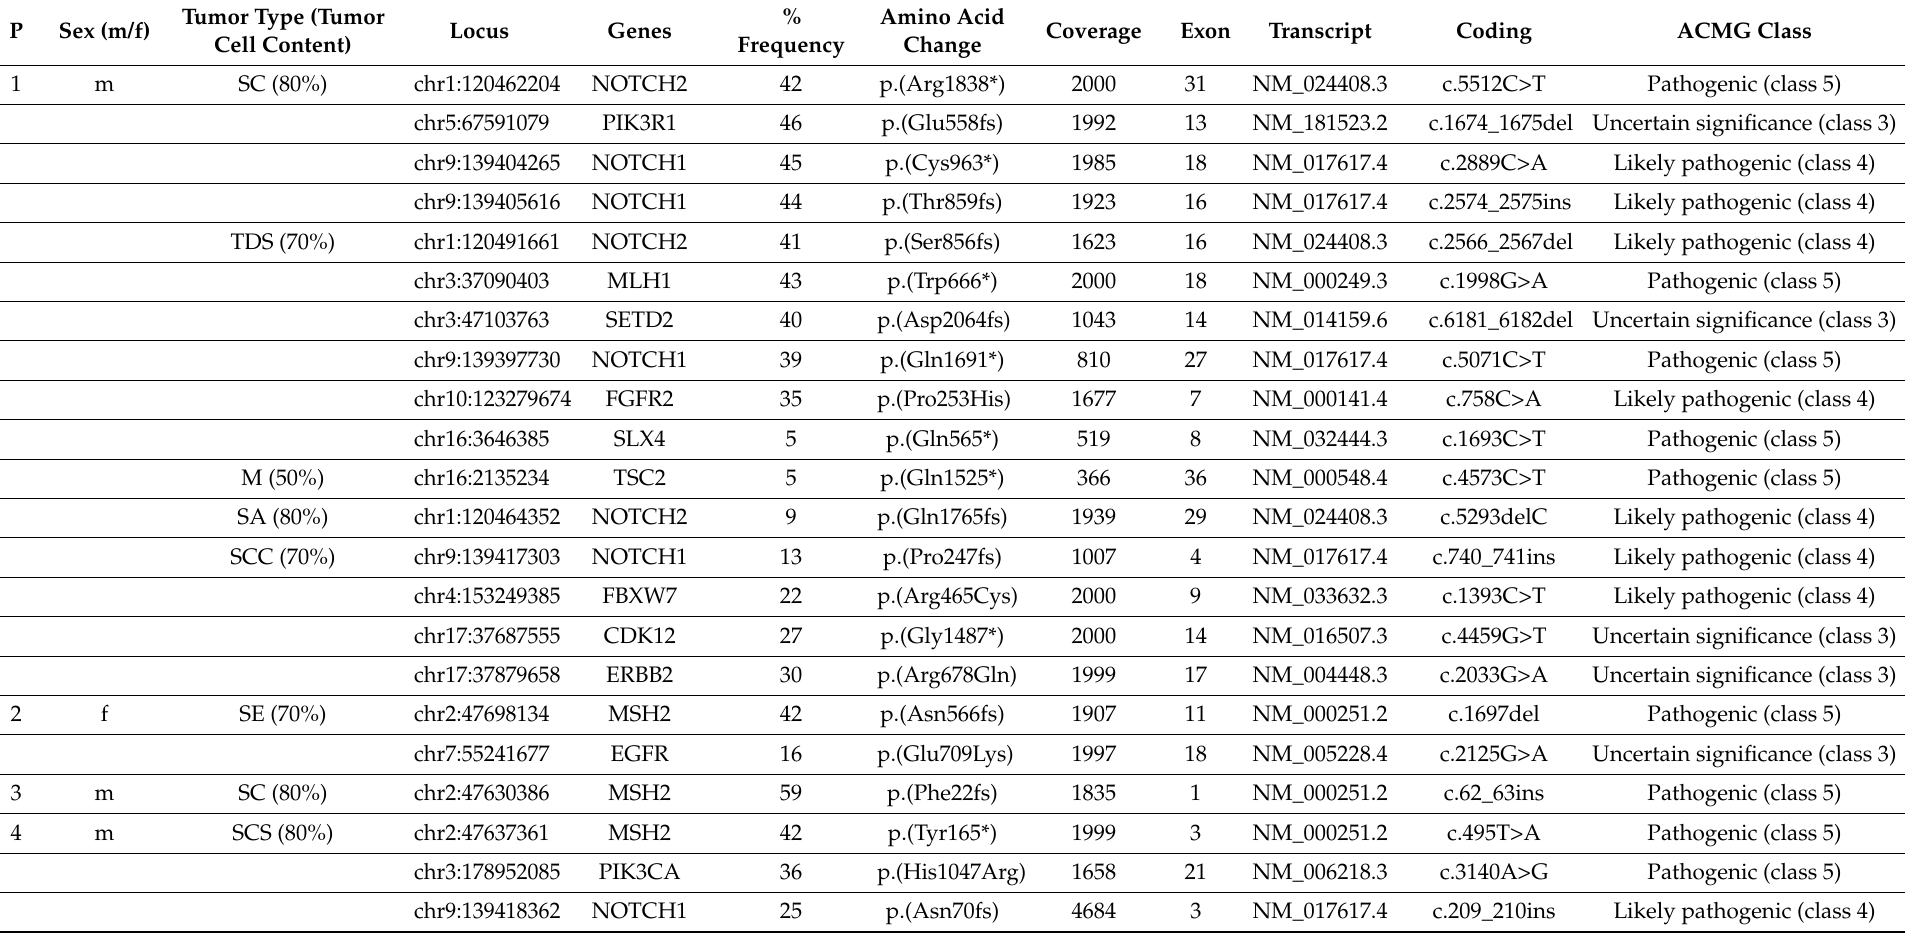
Table 4. Patient’s collective and mutational